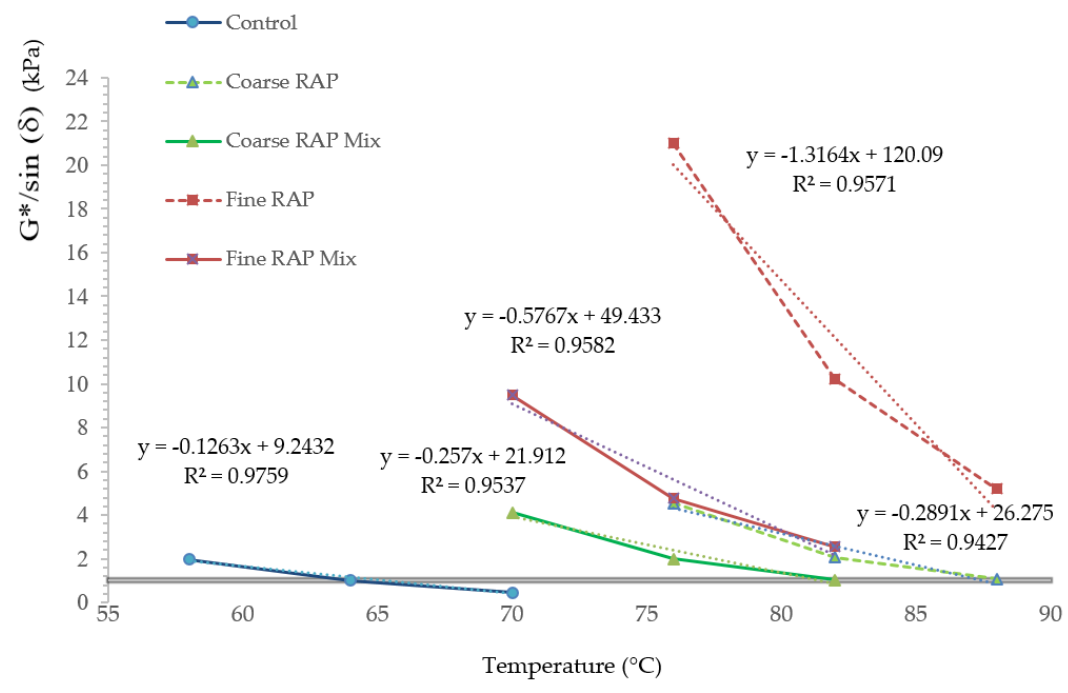
Figure 3. Performance grade of recovered bitumen by dynamic shear rheometer (DSR) at 1.6 Hz.